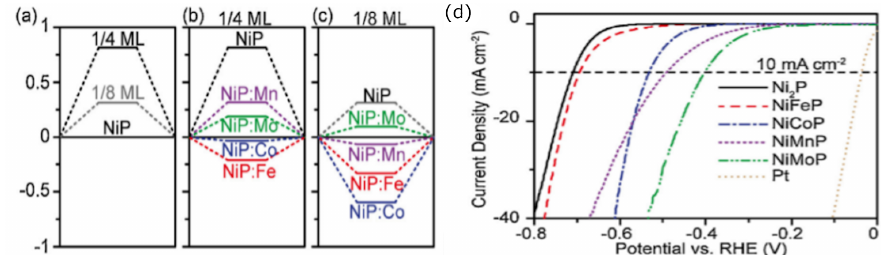
Figure 12. ( a ) ∆ G H of NiP with different degrees of H coverage, ( b ) ∆ G H NiP and transition-metal- doped NiP at 1/4 H coverage, ( c ) ∆ G H NiP at a 1/8 H coverage. ( d ) LSV for each